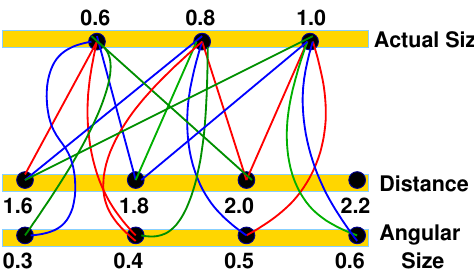
Figure 5. Schematic of a mapping from two variables, distance and angular size, to the emergent constant size of an object. The yellow bands show parametric spaces, while a black dot within the space represents a range of values. A convergent mapping in the same color onto the dots in the upper band represents a conjunction of values in distance and angular size that map to the resultant value in size. The convergence of multiple color combinations on the same dot represents terms in